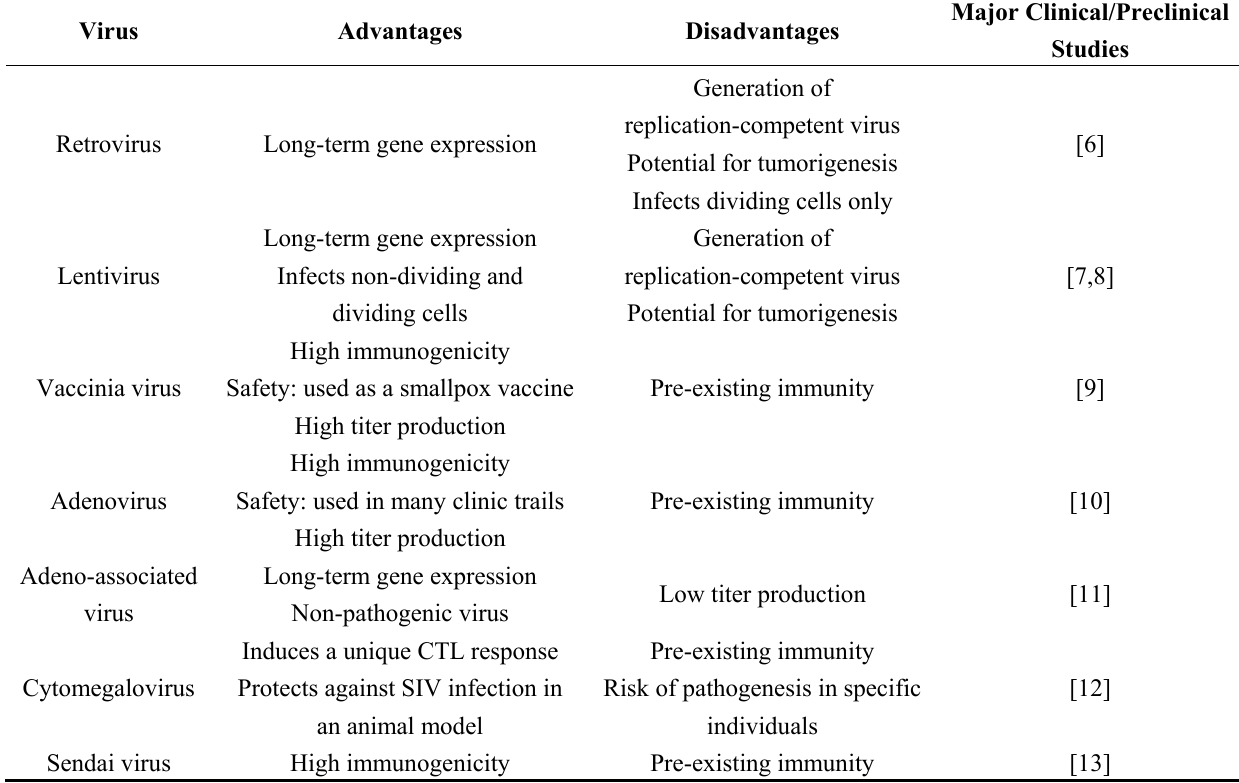
Table 1. Advantages and disadvantages of major viral